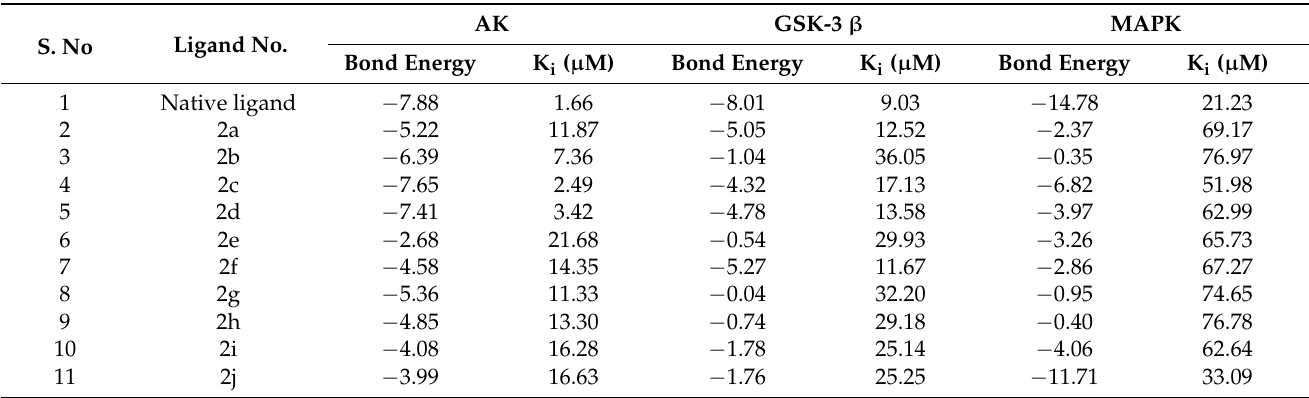
Table 4. Docking results against adenosine kinase, glycogen synthase kinase-3 β , and mitogen- activated protein kinase 1.